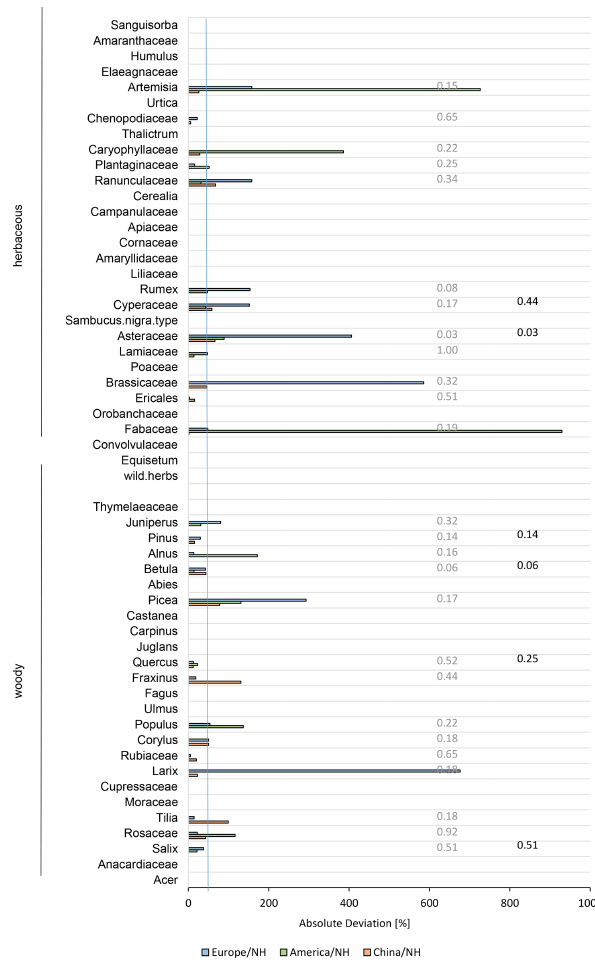
Figure 4. Absolute percent deviation of the northern hemi- spheric relative pollen productivity (RPP) dataset v2 to each continental RPP dataset. Deviation is calculated by ABS((RPP continent − RPP NH ) / RPP continent ) × 100. The blue line indicates an absolute deviation of 50%. Numbers on the right are p values of a Kruskal–Wallis test of each taxon between the three continents. Results shown in grey included each RPP set with data and black coloured values only those with N > 2 RPP values in at least two